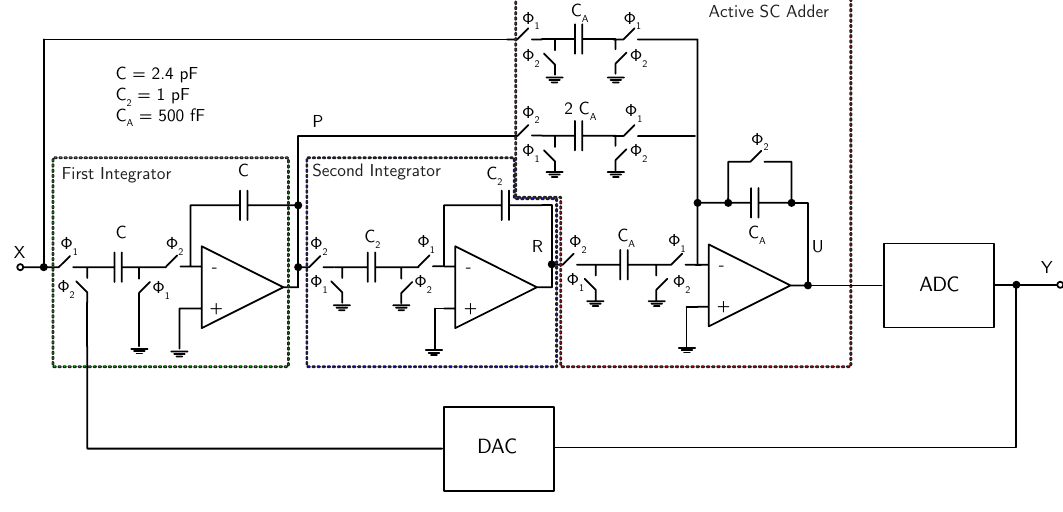
Figure 12. Schematic of the SC implementation of the DT analog second-order ΣΔ modulator (example